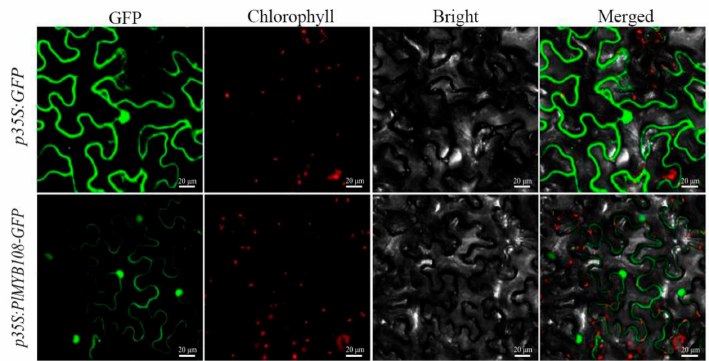
Figure 4. Subcellular localization of PlMYB108 in tobacco leaves. Note: From left to right are superimposed photos of GFP (green fluorescent protein), chloroplast autofluorescence, bright field, and three channels of target gene/empty vector,